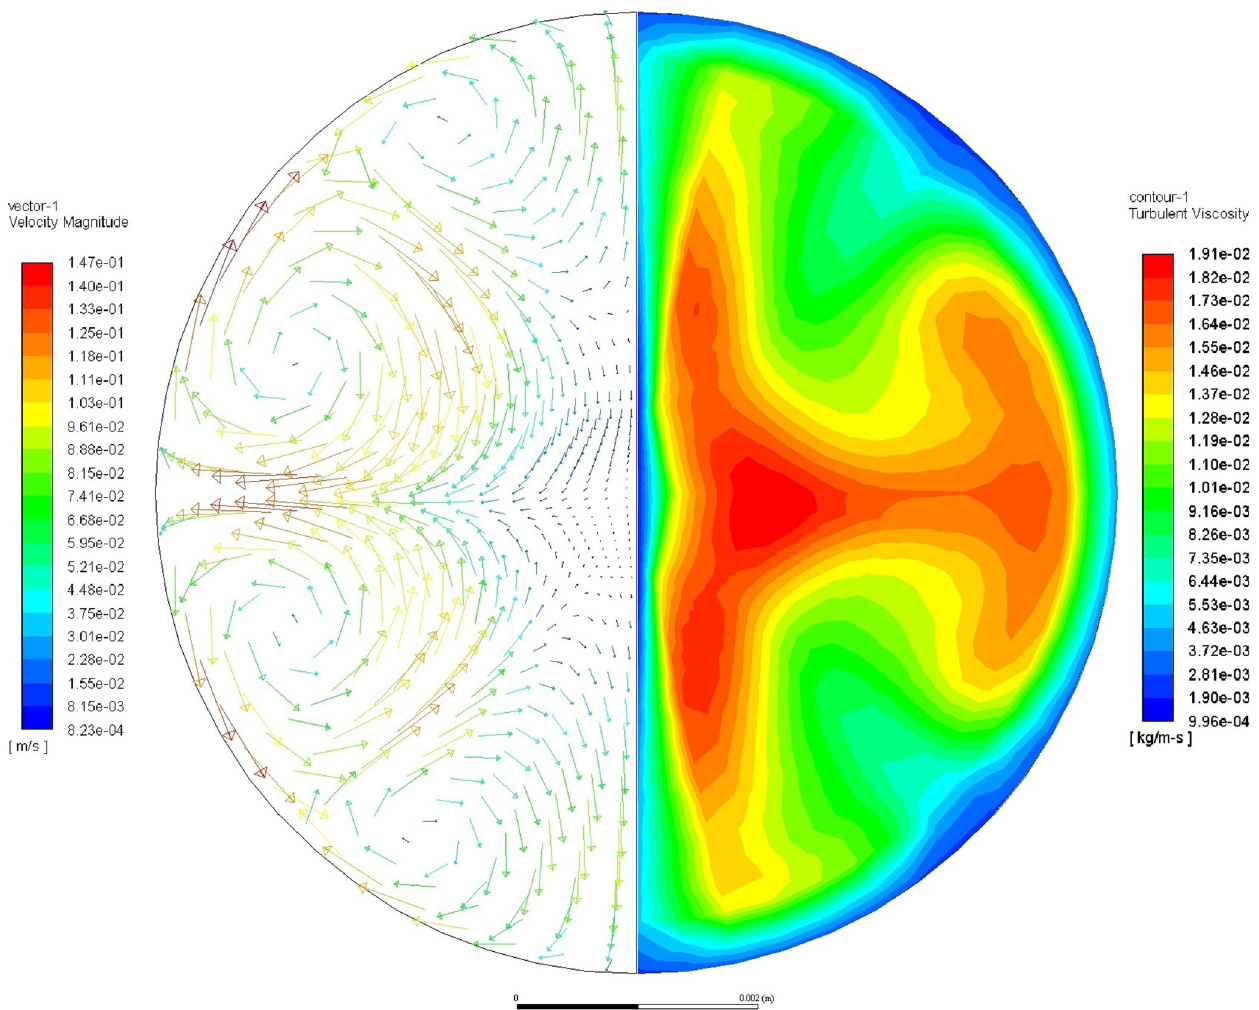
Fig. 2 The internal fl ow within the molten germanium sample at the time of the ISS- ML measurement. The velocity vectors are plotted on the left-hand side in which the fl ow is driven into the sample at ±45° from the equator of the sample. The turbulent viscosity contours are plotted on the right-hand side, which provides a measure of the kinetic energy is dissipated by the turbulent